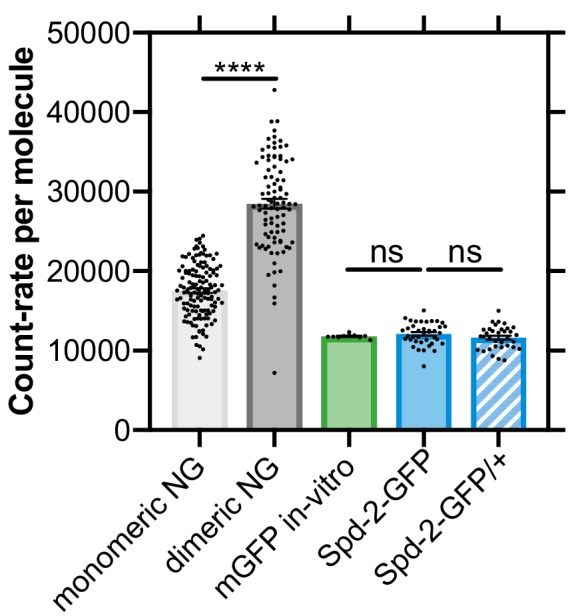
Spd-2-GFP diffuses as a monomer in the cytoplasm.Fluorescence Correlation Spectroscopy (FCS) allows one to calculate a fluorescent count-rate per molecule (CPM); graph shows the CPM of various fluorescent proteins, measured in living embryos, as indicated (mean ± SEM). Measurements from embryos expressing monomeric or dimeric NeonGreen illustrate how the CPM can clearly distinguish monomeric and dimeric proteins within living Drosophila embryos. As expected from their fluorescent properties, monomeric GFP (mGFP), here measured in vitro, exhibited a lower CPM than mNeonGreen, but Spd-2-GFP exhibited a nearly identical CPM to mGFP—indicating that Spd-2-GFP is monomeric in the embryo cytoplasm. To further confirm that Spd-2-GFP is monomeric in the cytoplasm, we compared the CPM of Spd-2-GFP in embryos expressing only Spd-2-GFP (Spd-2-GFP) and embryos expressing one copy of Spd-2-GFP and one copy of the endogenous unlabelled Spd-2 gene (Spd-2-GFP/+). No change in the CPM was observed, indicating that the Spd-2-GFP molecules cannot dimerise with the endogenous unlabelled Spd-2 to form a dimer with a reduced fluorescence. Every data point represents the average of the 6 × 10 s FCS recordings of an individual embryo. Statistical significance was assessed using unpaired t-test (****p<0.0001; ns = non significant).10.7554/eLife.50130.023Figure 5—figure supplement 1—source data 1.Figure 5—figure supplement 1 source data; FCS analysis.